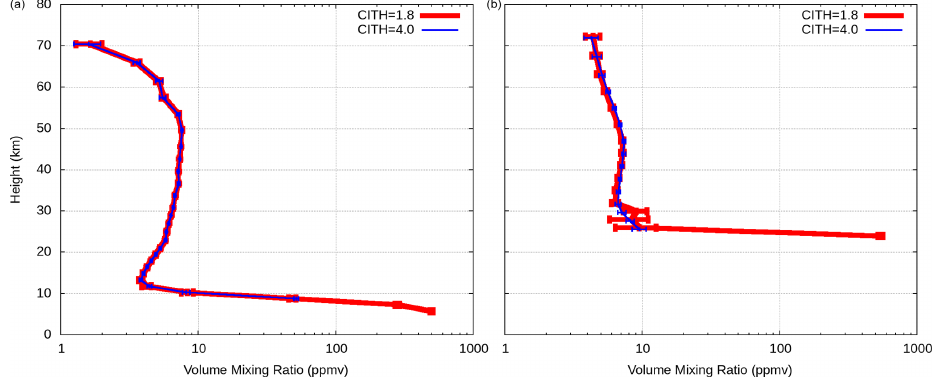
Figure 19. Water vapour profiles retrieved from scan 22 ( a , 63 ◦ N) and scan 71 ( b , 61 ◦ S) of orbit 33153 from 3 July 2008. Red profiles are retrieved after filtering the measurements with a CI threshold of 1.8, the blue profiles with a CI threshold of 4.0.